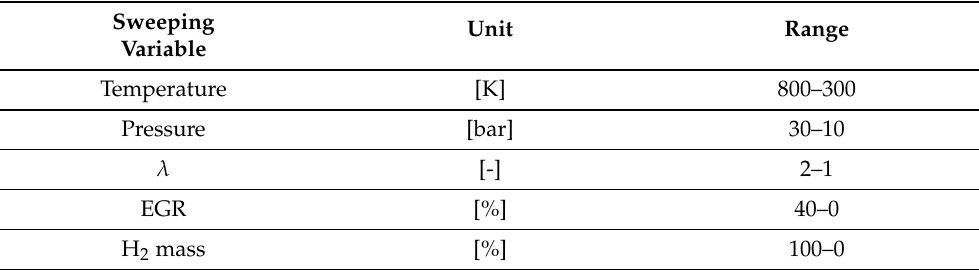
Table 3. Range of variables for the flame speed simulation table to feed the ANN